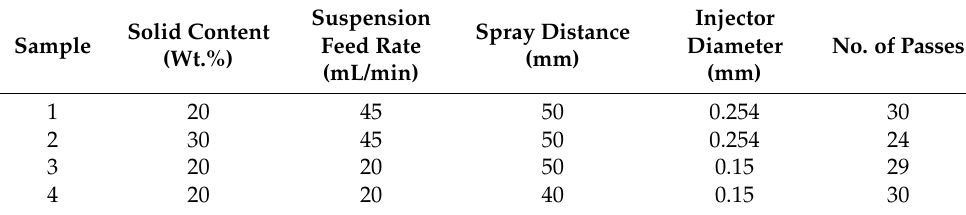
Table 2. Test matrix for the optimization